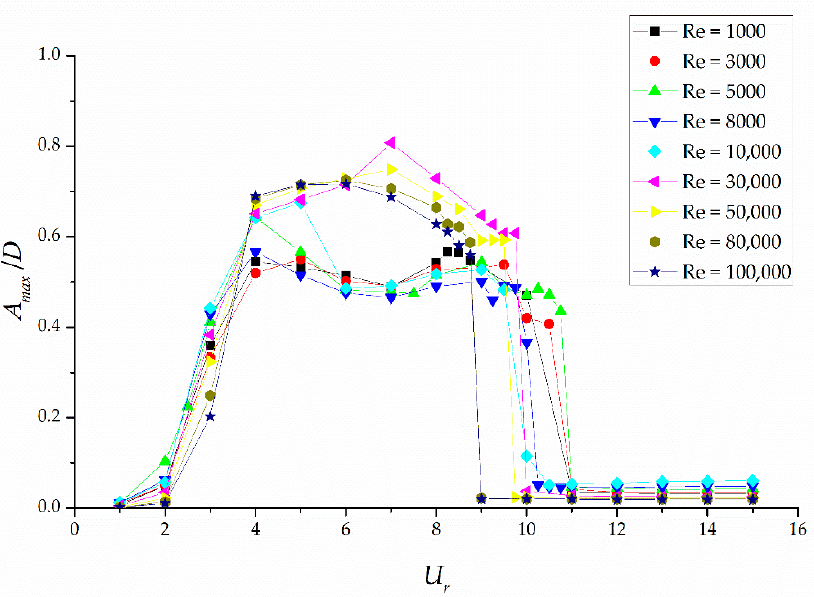
Figure 11. Vibration amplitude of SFT versus natural frequency in different Reynolds numbers.